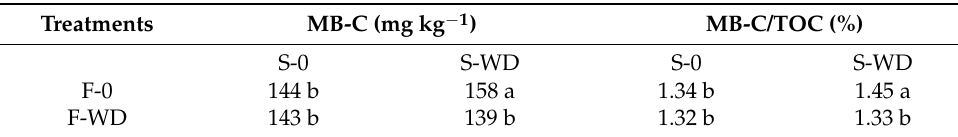
Table 2. Amount of soil biomass carbon (MB-C) and the MB-C/TOC ratio as affected by the interaction of wood distillate (WD) distribution as foliar spray (F) and soil irrigation (S). Data are means of three replicates ( n = 3). For each parameter, same letters indicate not significantly different means at p ≤ 0.05, Tukey